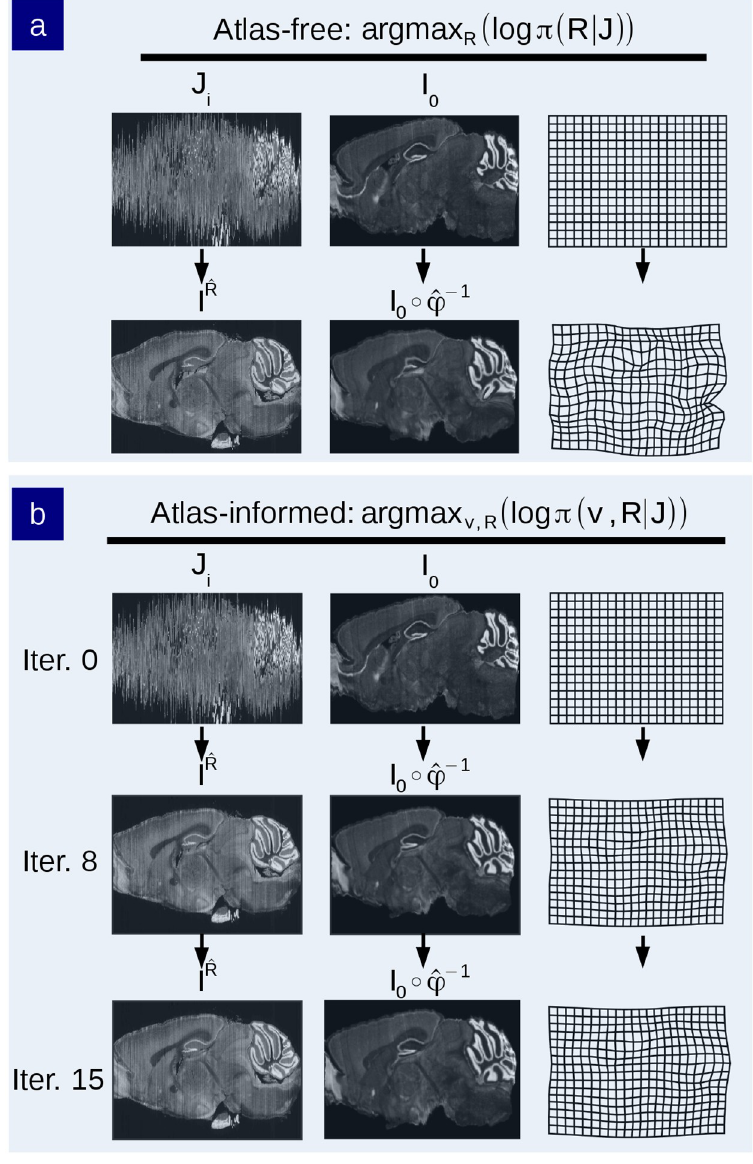
Fig 8. Comparison of reconstruction and mapping using atlas-free and atlas-informed models on data from the MBAP database. a) Reconstruction of an MBA Nissl-stained brain histological stack using the atlas-free method. Top row shows the histological stack and Allen mouse brain atlas. Bottom row shows the reconstructed histological stack I ^ R alongside the deformed phantom atlas I , and the diffeomorphic change of coordinates ^ φ (cid:0) 1 . b) Reconstruction using the atlas-informed method. Top row shows the histological stack and Allen mouse brain atlas. Middle row depicts intermediate iterations of the reconstructed stack I ^ R alongside the deformed atlas I � ^ φ (cid:0) 1 and coordinate grid. Bottom 0 row shows the convergence point of algorithm.